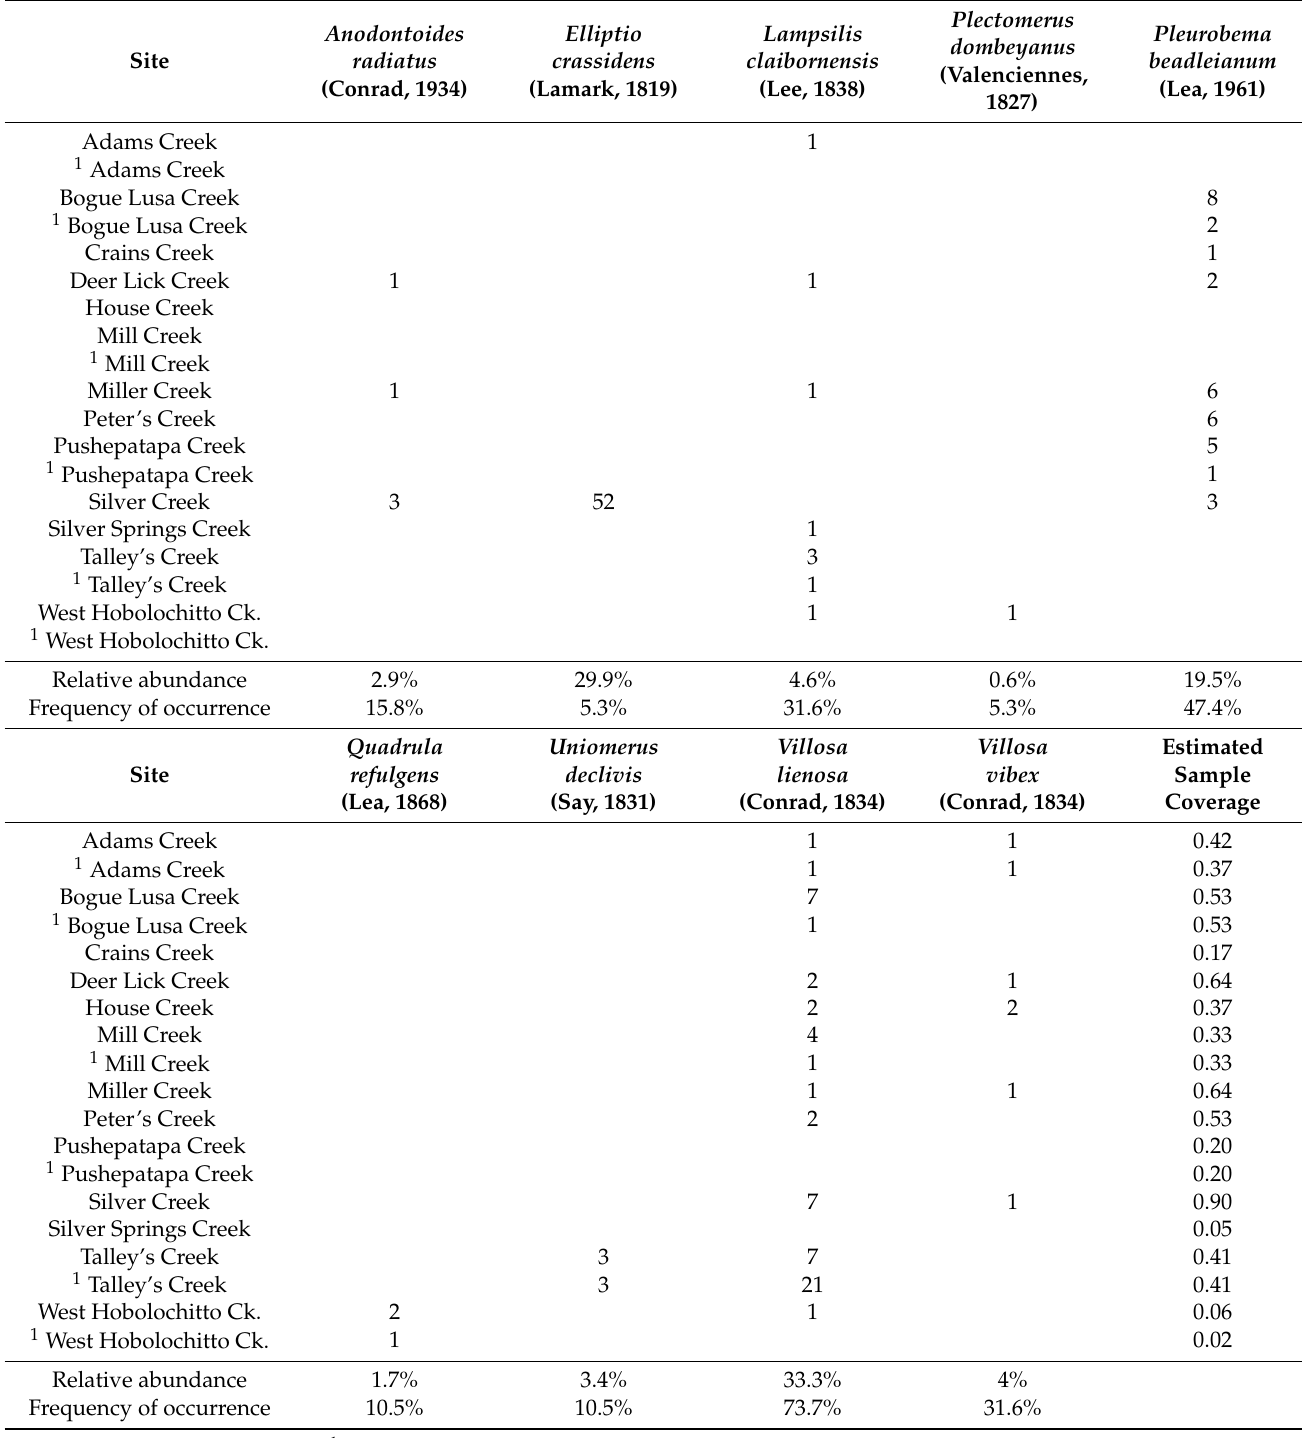
Table 1. Sites where mussels were collected in Pearl River tributary streams during 2015 and 2016. Data include number of each species at each site, relative abundance (percentage of total mussels collected within a site), frequency of occurrence (percentage of sites occupied by each species), and estimated sample coverage based on Chao and Jost [52]. Collections at Ben’s Creek, Hays Creek (2 reaches), Lawrence Creek (2 reaches), Peter’s Creek (2nd visit), Peter’s Cutoff, Pushepatapa Creek (2nd visit), Sal’s Branch, Stubb’s Creek, Talisheek Creek, Thomas Creek, and West Hobolochitto Creek (2nd reach) yield no mussels and are not